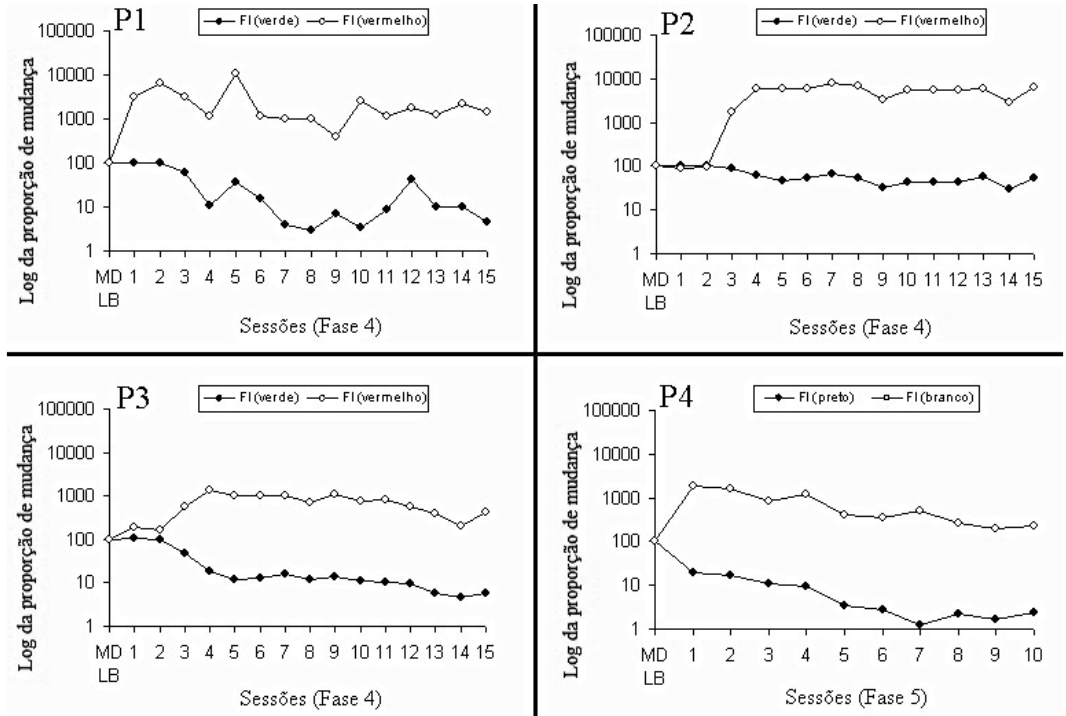
Figura 3. Proporção de mudança das taxas de respostas em relação à linha de base nos componentes do múltiplo FI-FI nas Fases 4 (P1, P2 e P3) e 5 (P4). Os pontos cheios e vazios indicam componentes com botão verde (correlacionados ao FR na Fase 3) e vermelho (correlacionados ao DRL na Fase 3), respectivamente. Para P4 os pontos cheios e vazios indicam componentes com botão preto e branco, respectivamente. A proporção foi calculada dividindo-se a taxa de respostas em cada componente, em cada sessão, pela média da taxa de respostas de cada componente nas quatro últimas sessões da Fase 3 (P1, P2 2 P3) e 4 (P4). O resultado foi multiplicado por 100, transformando-o em porcentagem de mudança da taxa de respostas nas sessões de teste em relação à linha de base. A escala do eixo Y em cada grá fi co é logarítmica (base 10).